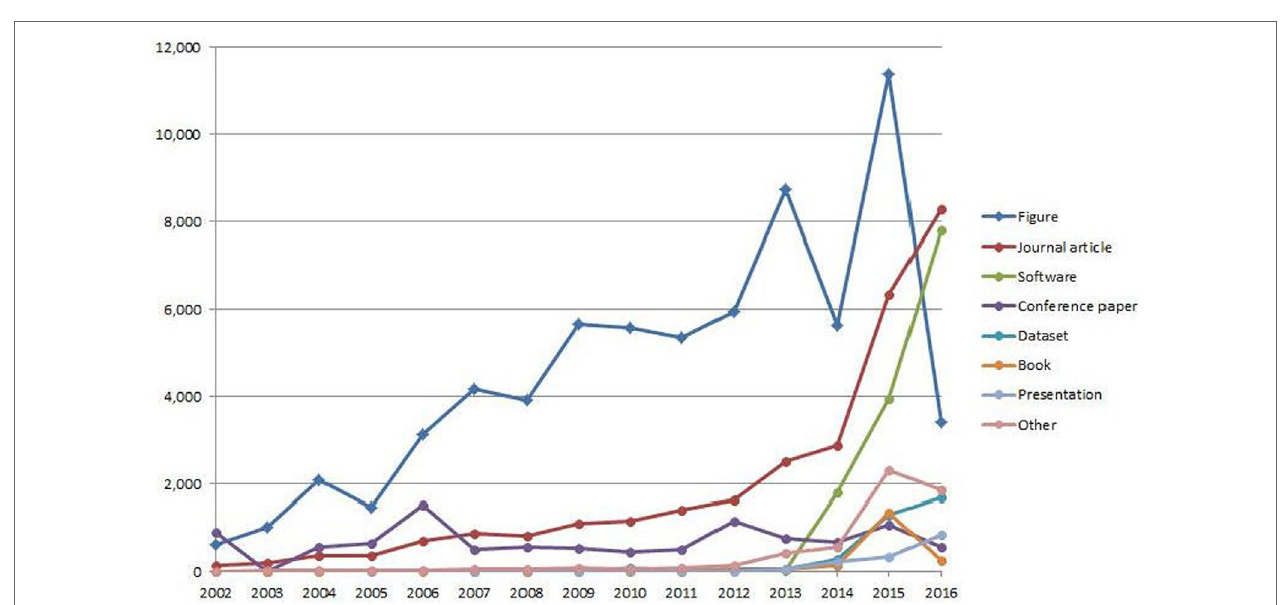
FigUre 1 | All data record types per publication year in Zenodo with digital object identifier and publication years 2002–2016 ( n = 133,917 records).